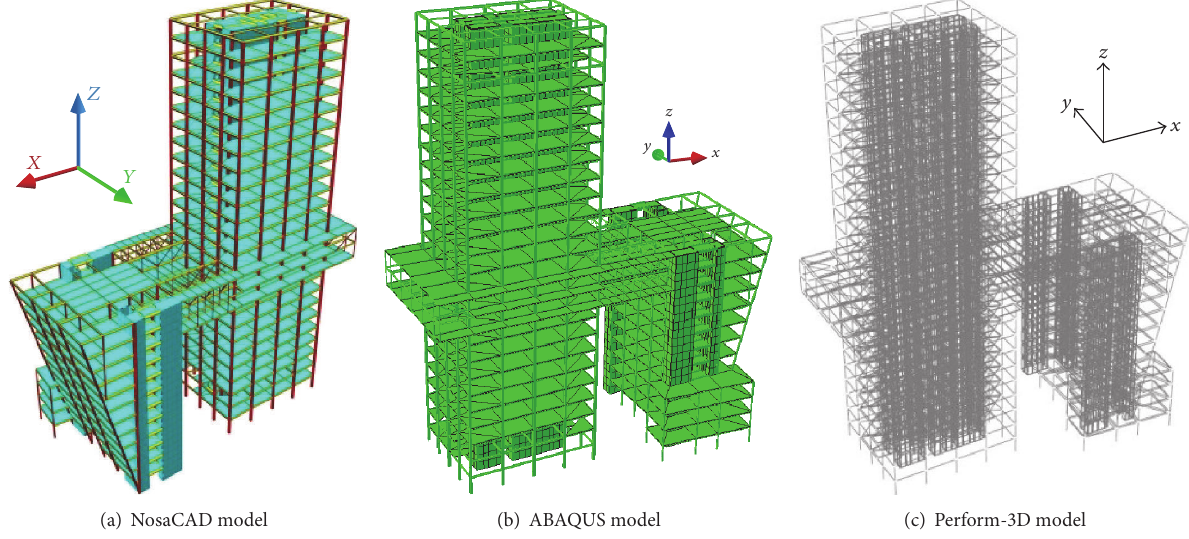
Figure 11: The models of structure.